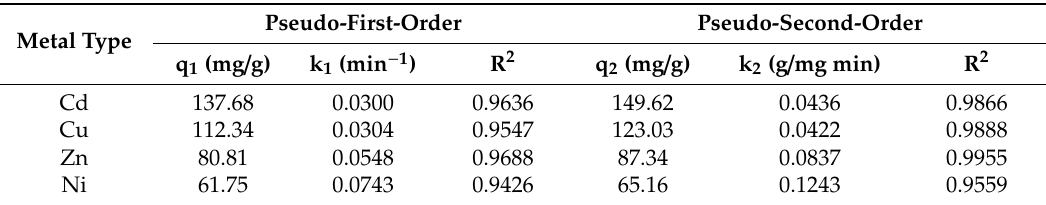
Table 1. Parameters of pseudo-first-order and pseudo-second-order kinetic models. q 1 and q 2 = the amount of metal ions adsorbed at equilibrium; k 1 and k 2 = equilibrium rate constants of the pseudo-first-order and pseudo-second-order, R 2 = coe ffi cient of determination,